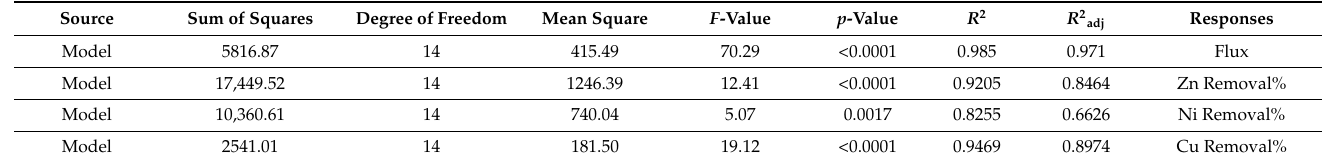
Table 2. ANOVA analysis for the NF